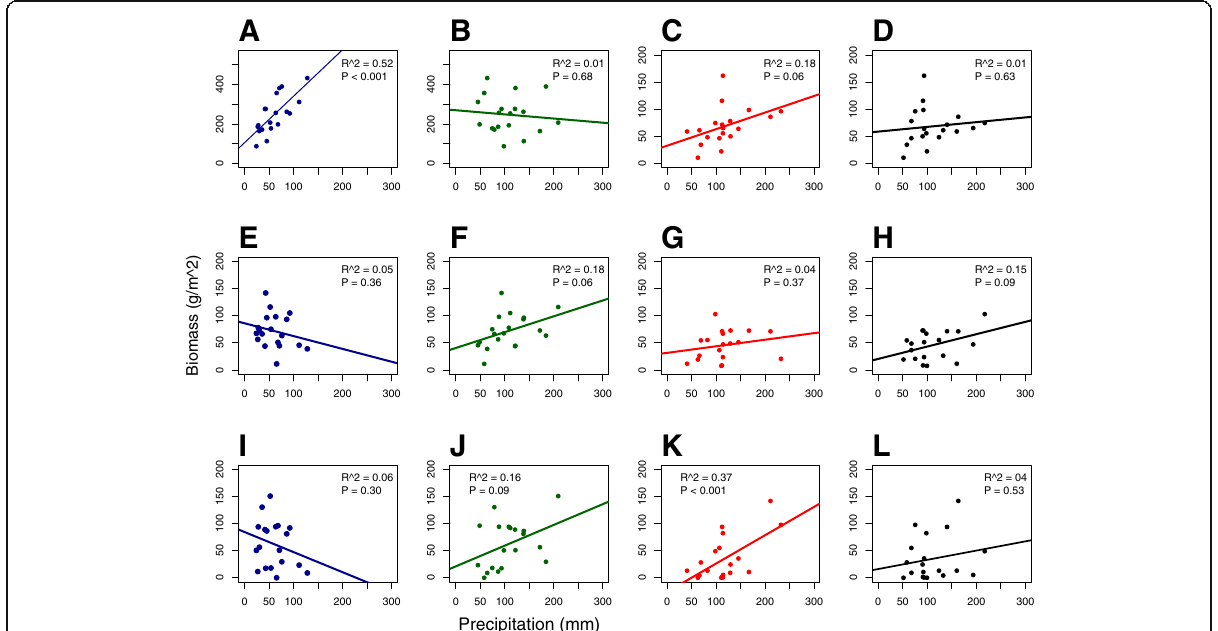
Fig. 9 Response of functional group aboveground biomass productivity to early and late growing precipitation in June and September. Relationships of aboveground biomass productivity of the functional group of grasses with early growing season precipitation in June ( a ), late growing season precipitation in June ( b ), early growing season precipitation in September ( c ), and late growing season precipitation in September ( d ) harvests. Relationships of aboveground biomass productivity of the functional group of herbs with early growing precipitation in June ( e ), late growing precipitation in June ( f ), early growing precipitation in September ( g ), and late growing precipitation September ( h ) harvests. Relationships of aboveground biomass productivity of the functional group of legumes with early growing precipitation in June ( i ), late growing precipitation in June ( j ), early growing precipitation in September ( k ), and late growing precipitation September ( l